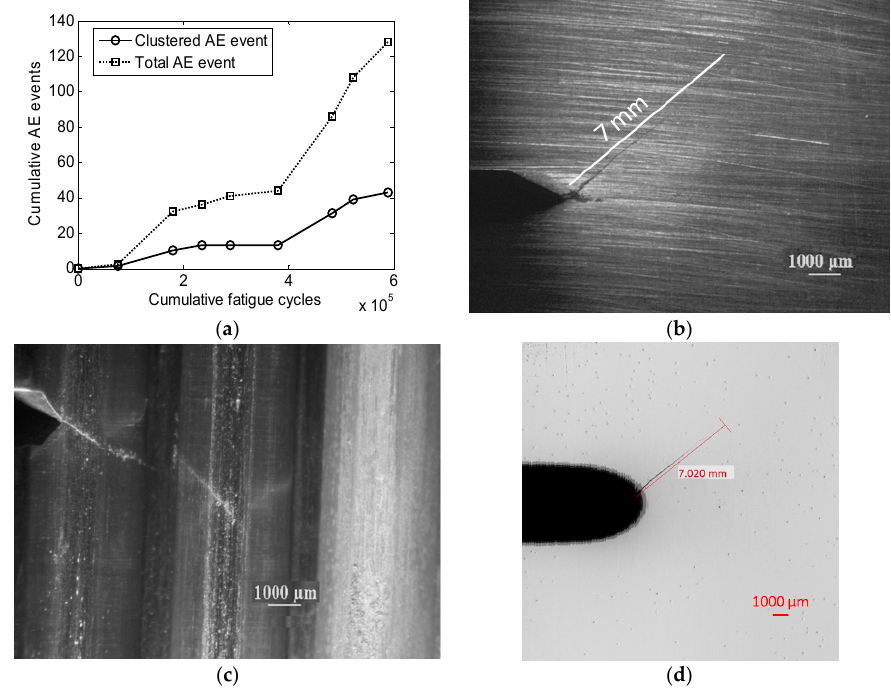
Figure 9. ( a ) Cumulative AE events and fatigue cycles, microscopic image of crack growth; ( b ) back surface; ( c ) front surface; and ( d ) Sonoscan microscopic image.